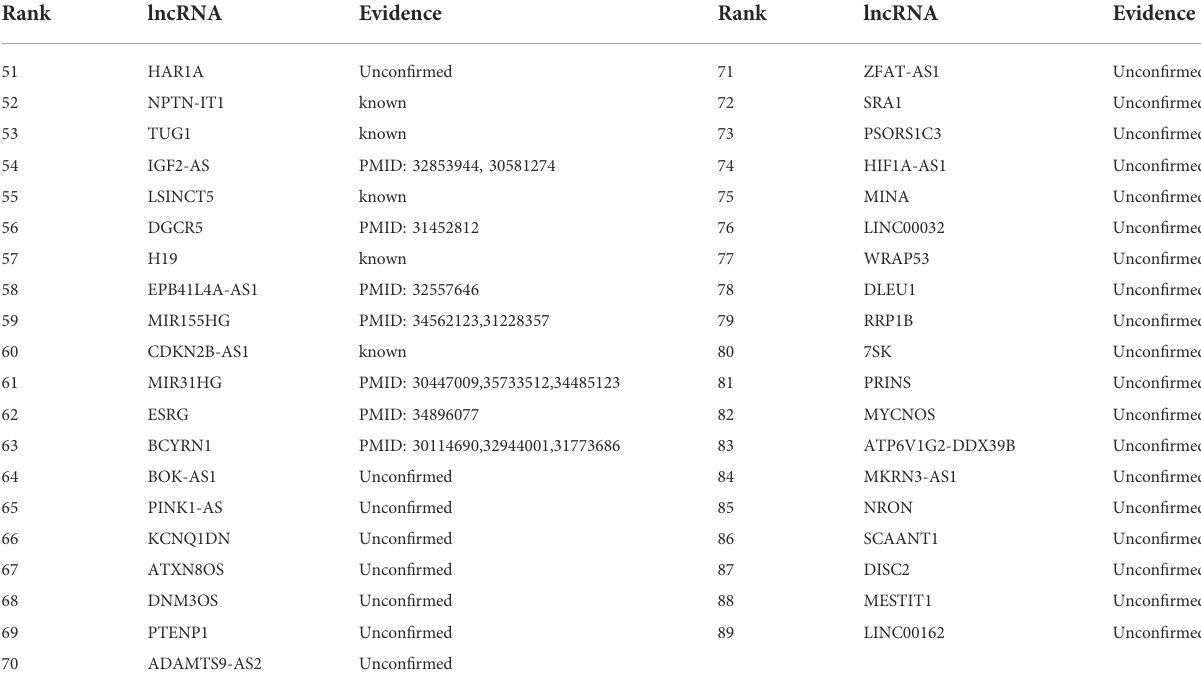
TABLE 5 The rankings of the remaining 41 lncRNAs according to association with breast cancer on the MNDR dataset.